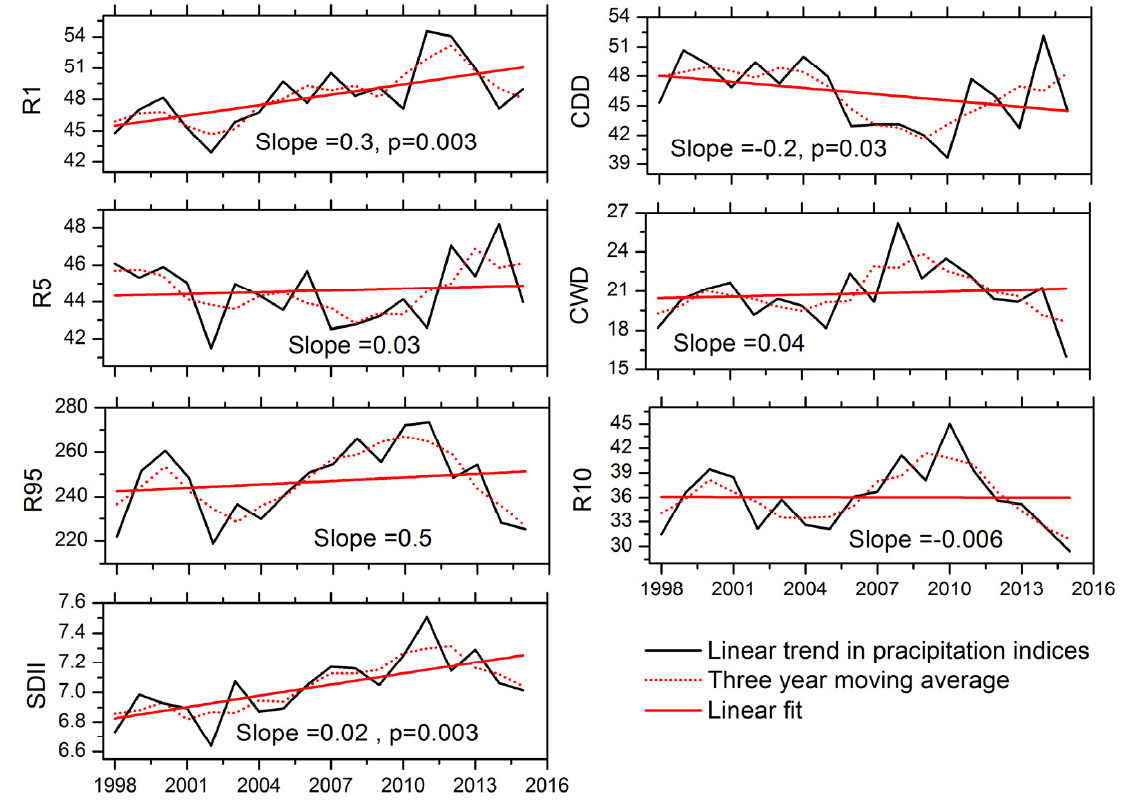
Figure 4. Area averaged time series in extreme precipitation climate change indices. The black line indicates the area average time series of climate change indices. Dotted and solid red lines represent a three-year running average and linear fit in climate change indices. The significant trends are shown with corresponding p